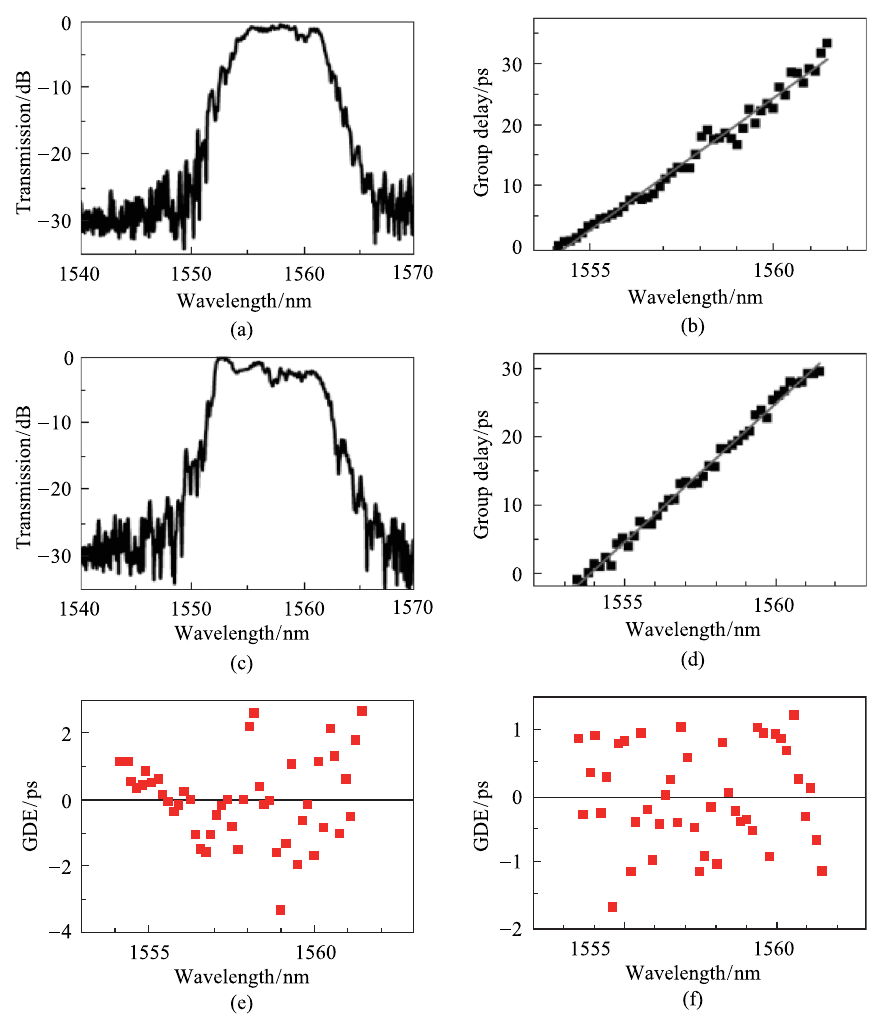
Fig. 6 Measured transmission, group delay, and GDE spectra of the contra-directionally coupled chirped Bragg grating waveguides with linearly increasing waveguide width ( a , b and e ), and nonlinearly corrected waveguide width ( c , d and f